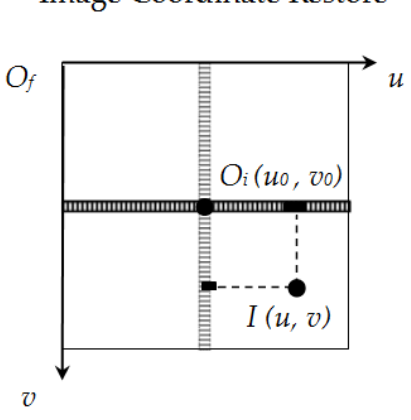
Figure 2. 2d image coordinate of the target point I ( u , v ) can be restored by two 1d images.